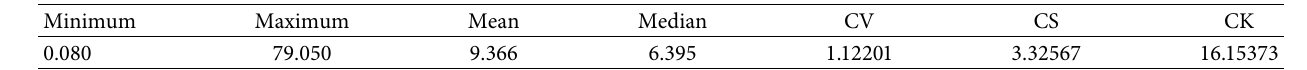
Figure 6: Fitted CDFs for annual unemployment rate dataset. Table 12: Descriptive statistics of bladder cancer survival time.